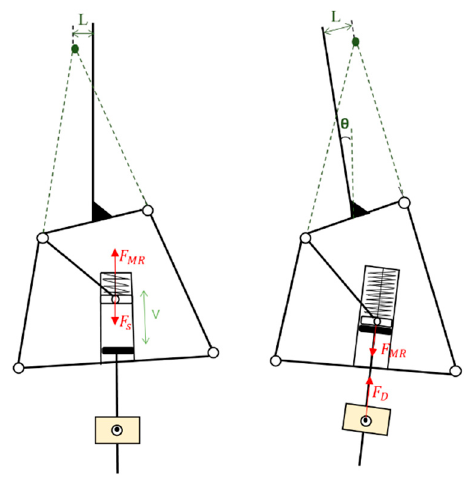
Figure 6. The force transmission of the prosthetic knee.